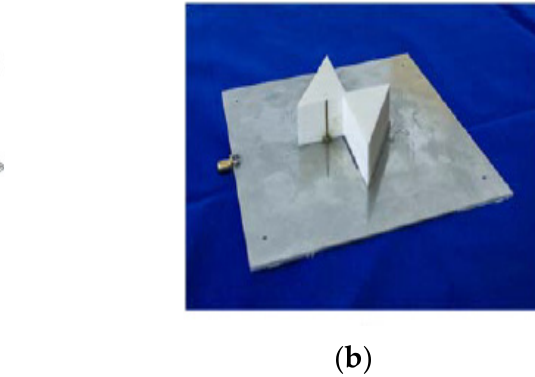
Figure 11. Proposed bowtie DRA: ( a ) 3D view; ( b ) fabricated DRA [28].